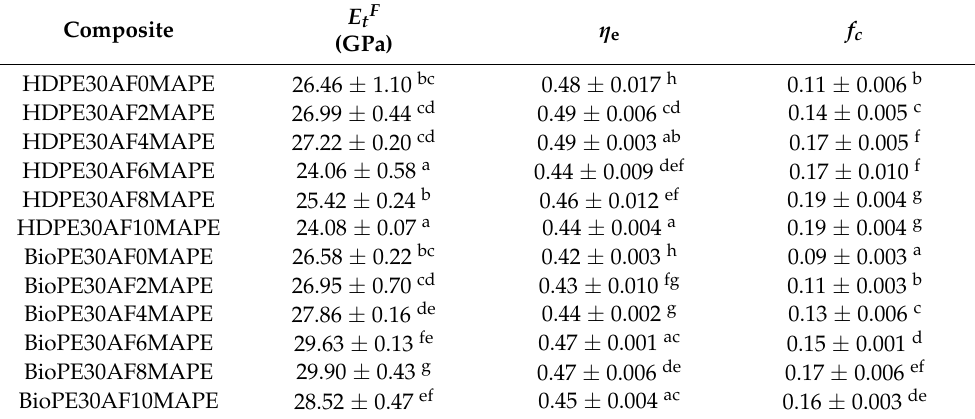
Table 4. Influenceofcouplingagentcontentsoverthetensilepropertiesof30wt%AFreinforcedcomposites.